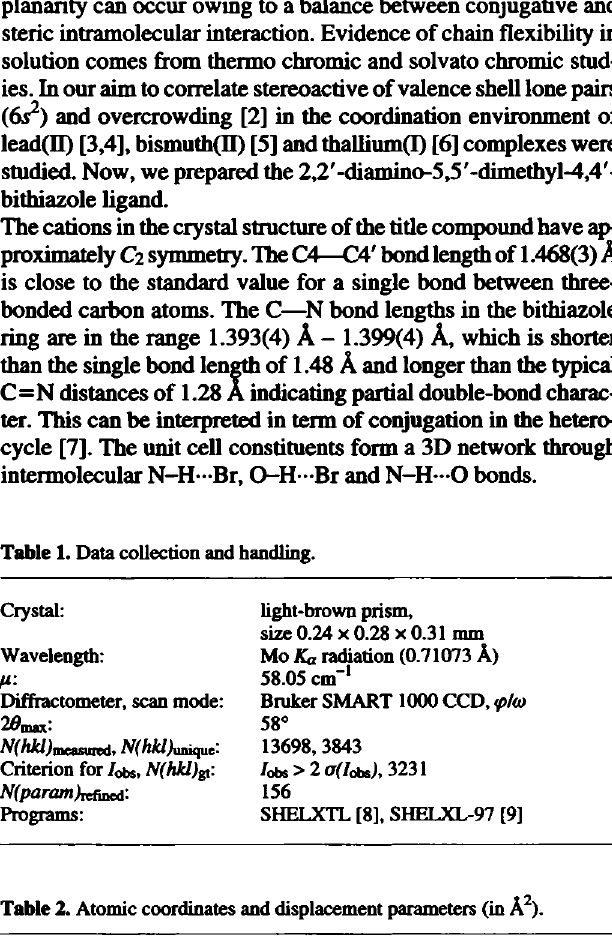
Table 2. Atomic coordinates and displacement parameters (in A 2